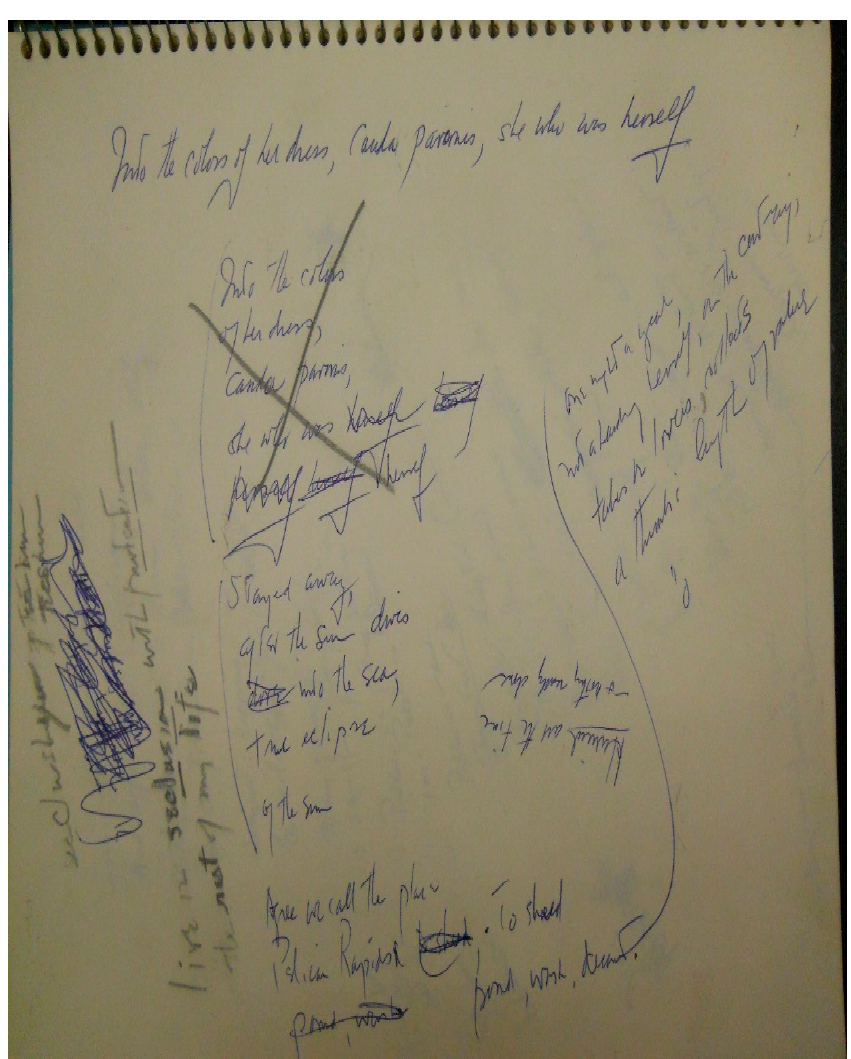
Figure 5. Page from “Notebook. No. 150. October 1964–December 1964”, box 65, CORC. My transcription omits the side-notes to the left (to which we will return) and also the two upside-down lines mid-page.